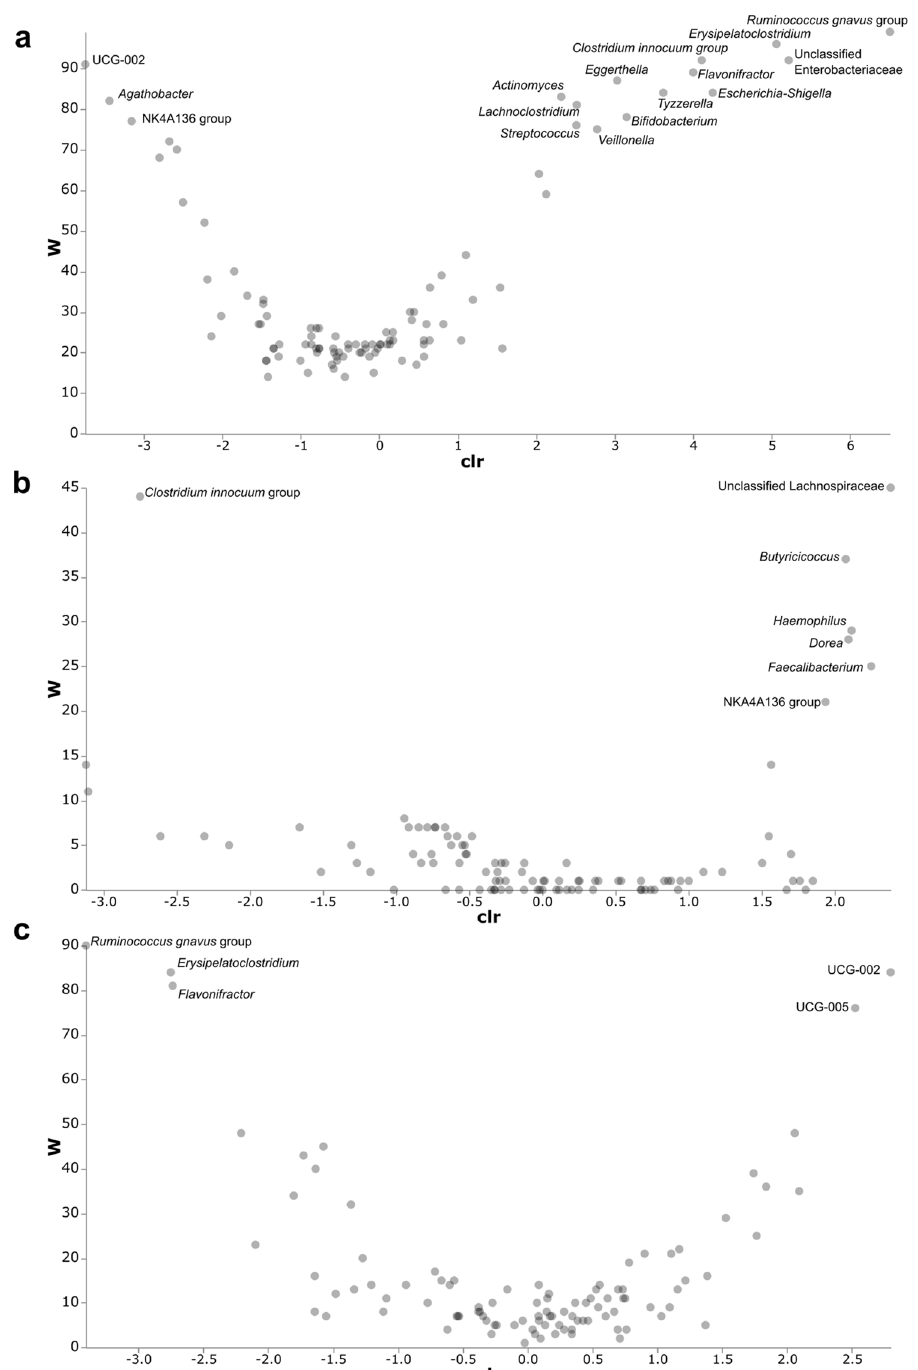
Figure 5. ANCOM generated volcano plots showing differentially abundant features between the age groups. W is the ANCOM test statistic and indicates the number of times the null hypothesis is rejected by the analysis. The higher W, the more likely a feature differs statistically. clr indicates the effect size change between the compared groups. Statistically significant features as identified by ANCOM have been labelled. ( a ) Comparison between groups A & C. A positive clr indicates higher abundance in A compared to C. ( b ) Comparison between groups A & B. A positive clr indicates higher abundance in B compared to A. ( c ) Comparison between groups B & C. A positive clr indicates higher abundance in C compared to